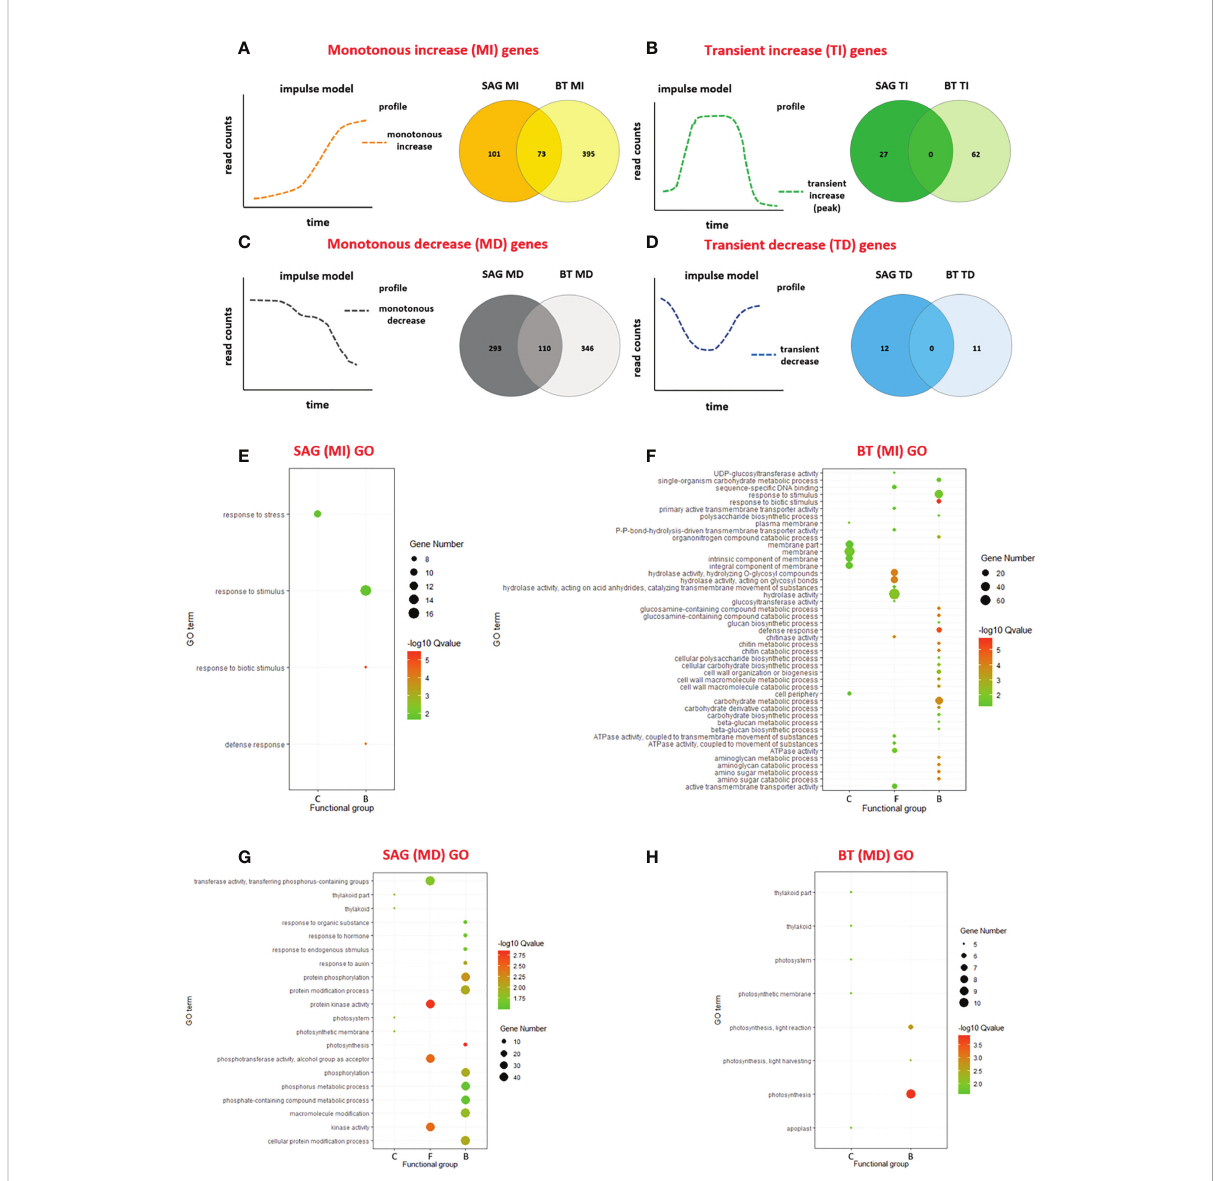
FIGURE 4 Differential expression in the two cultivars. Venn diagrams of shared and unique genes related to temporal pro fi les in the two cultivars, in the four different clusters MONOTONOUS INCREASE (MI) (A) , MONOTONOUS DECREASE (MD) (B) , TRANSIENT INCREASE (TI) (C) and TRANSIENT DECREASE (TD) (D) . GO enrichment analysis of MI and MD cluster genes in the two cultivars: MI genes in SAG (174) (E) , and BT (468) (F) ; MD cluster genes in SAG (403) (G) and BT (456) (H) , including C, cellular components; F, molecular functions and B, biological processes. The pathway enrichment analysis was performed with KOBASS, online tool, and the detailed information is presented as a bubble chart. The size of the bubbles represents the number of assigned genes, and the color of bubbles represents the -log10